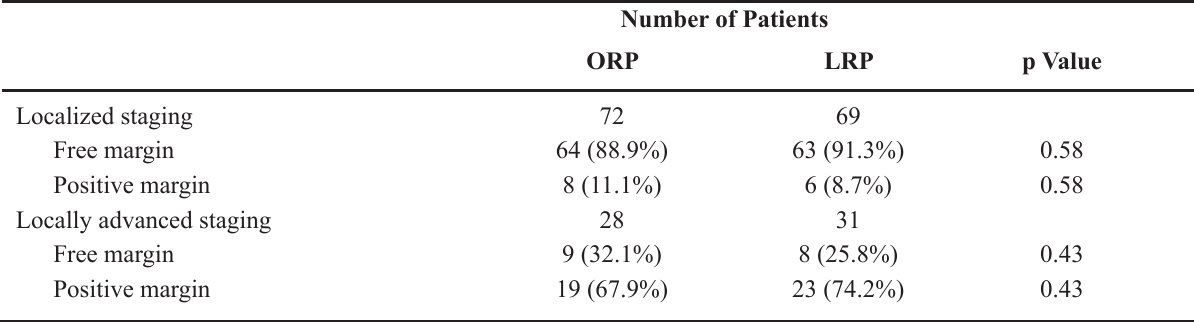
Table 3 – Surgical margin in pathological localized disease and pathological locally advanced disease between ORP and